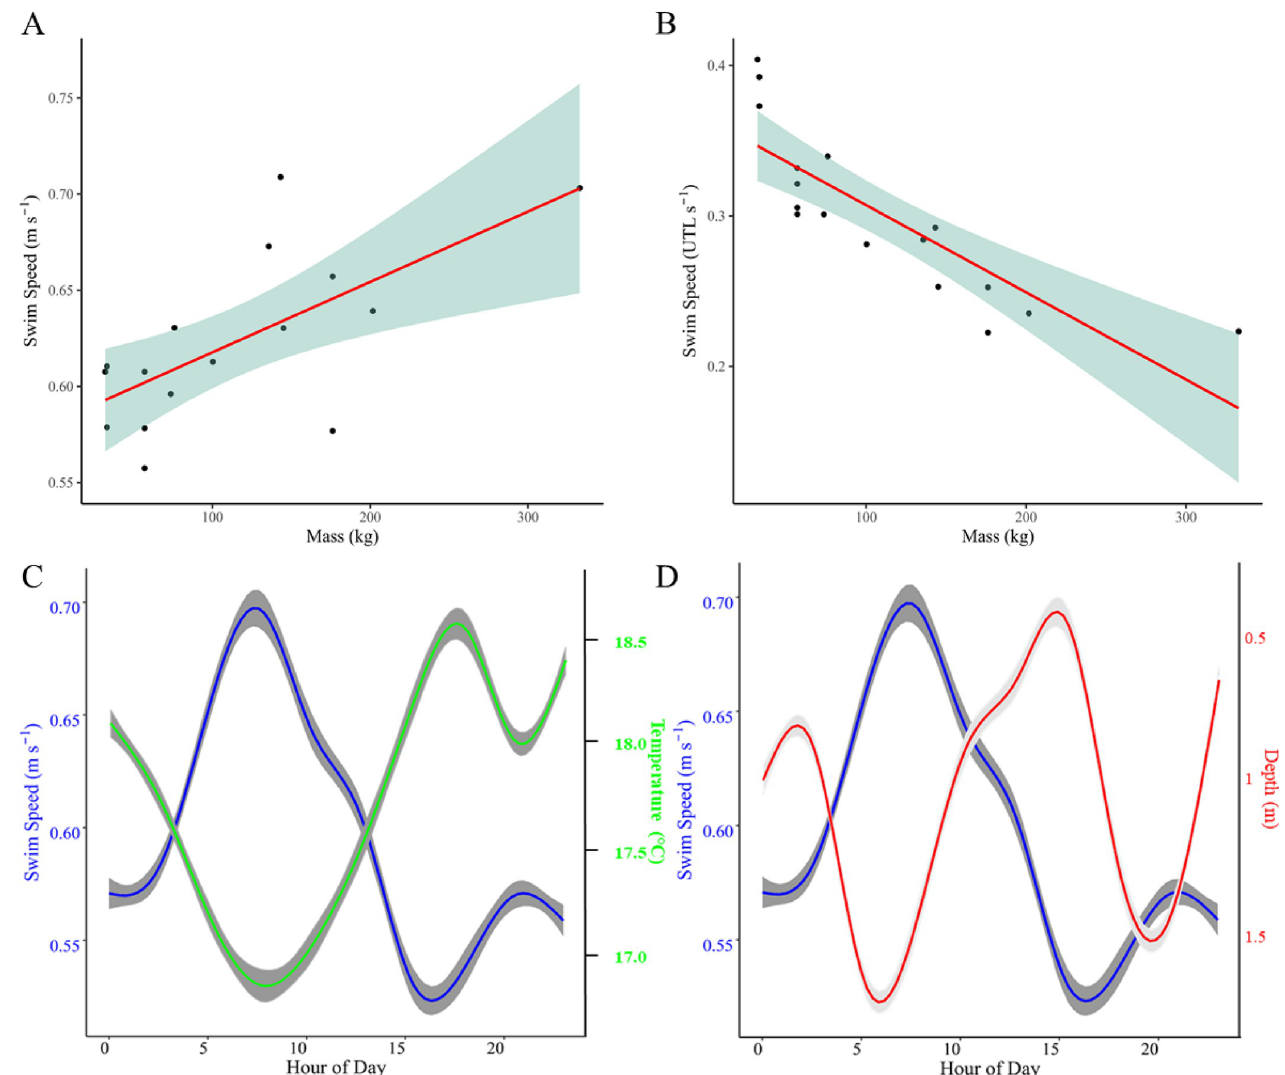
Fig 2. Relationship of cruising speed to shark size, diel period, temperature and depth. (A) Median values of raw cruising speeds (m s -1 ) for each shark were found to have a weak positive linear relationship to shark body size, described by the equation (SS H = 5.3x10 -5 (M) + 0.61). Data points show the mass (kg) and cruising speed (m s -1 ) of each shark included in the study. (B) Standardized to total length, a negative correlation between median cruising speed and body mass (size) was observed, with larger sharks effectively swimming more slowly than smaller sharks. Data points show the mass (kg) and cruising speed standardized to the total length of the animal (UTL s -1 ) for each shark included in the study. (C) Relationship between cruising speed (m s -1 , blue trace) and environmental temperature (green trace˚C) for the six sharks equipped with depth sensing tags. Trend line shows conditional smoothed mean values, grey shading indicates 95% confidence intervals. (D) Relationship between cruising speed and depth for the same six sharks. Blue trace indicates mean swim speed (m s -1 ), red trend line indicates mean swimming depth